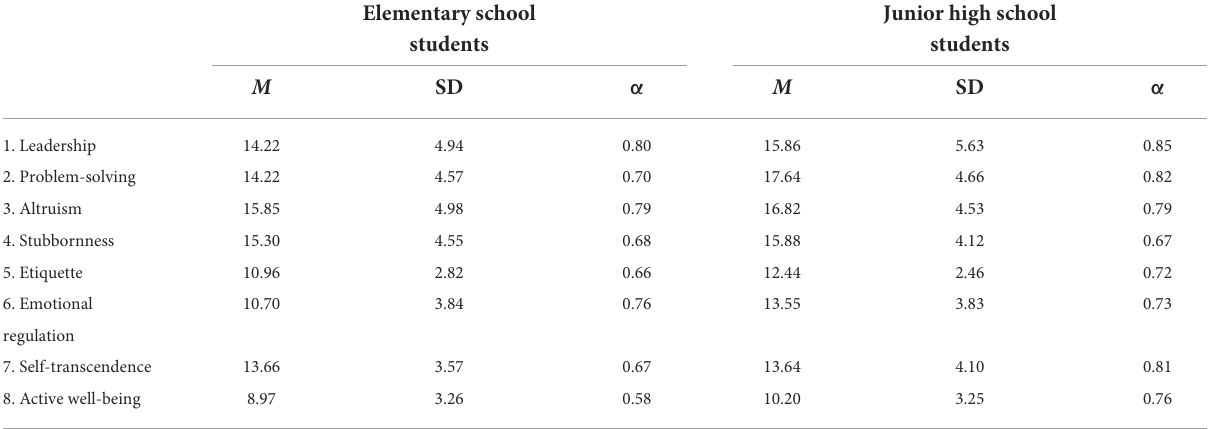
TABLE 3 Descriptive statics and Cronbach’s alpha of the power to live questionnaire (34-item factor